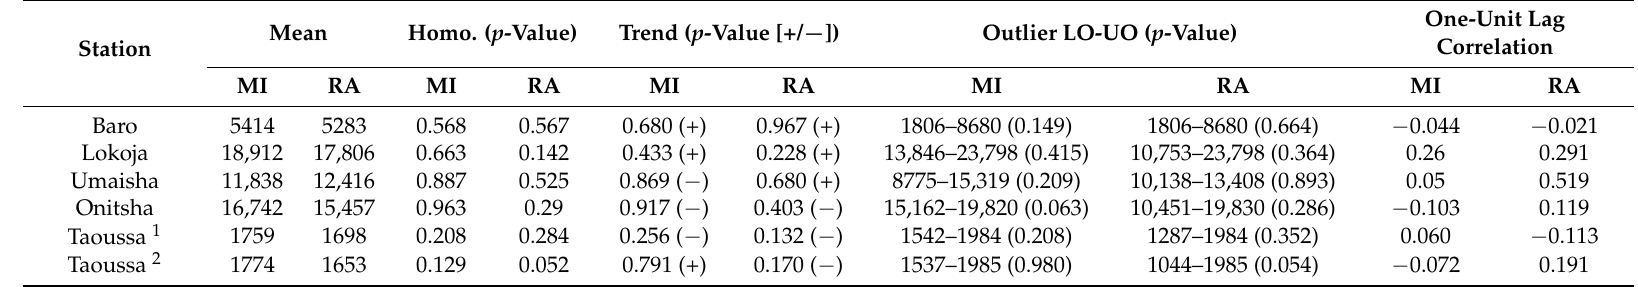
Table 4. Preliminary analysis results (mean, homogeneity, trend, outlier, serial